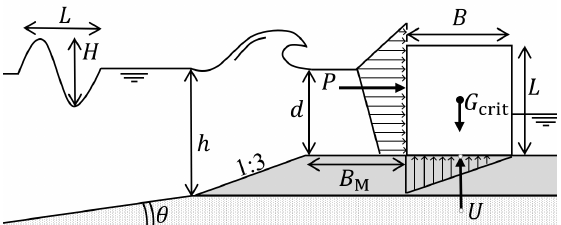
Figure 7. Schematic overview of sliding experiments such as performed by Tanimoto et al. [39] and used for the derivation of Takahashi’s impulsive pressure coefficient [32,33]. A similar set-up is expected for Goda’s sliding experiments in step